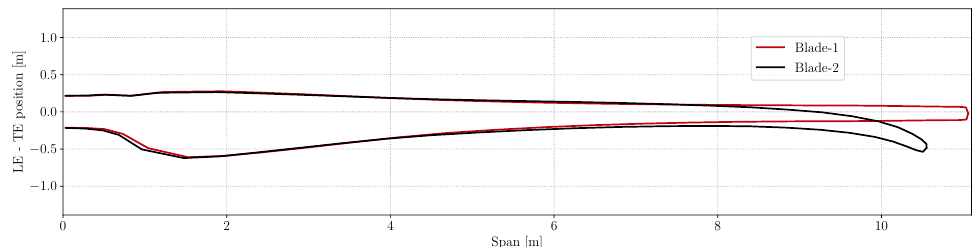
Figure 1. Leading edge and trailing edge positions of both blade designs along the blade spans. The scale ratio between horizontal and vertical axis is 4.